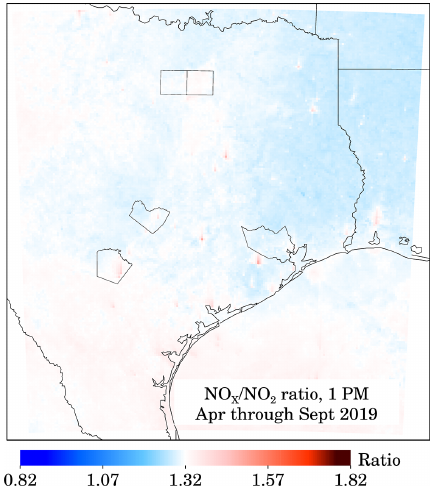
Figure C1. The NO x / NO 2 ratio at 13:00LT for April– September 2019 for partial NO 2 columns below 2km in altitude, as simulated by